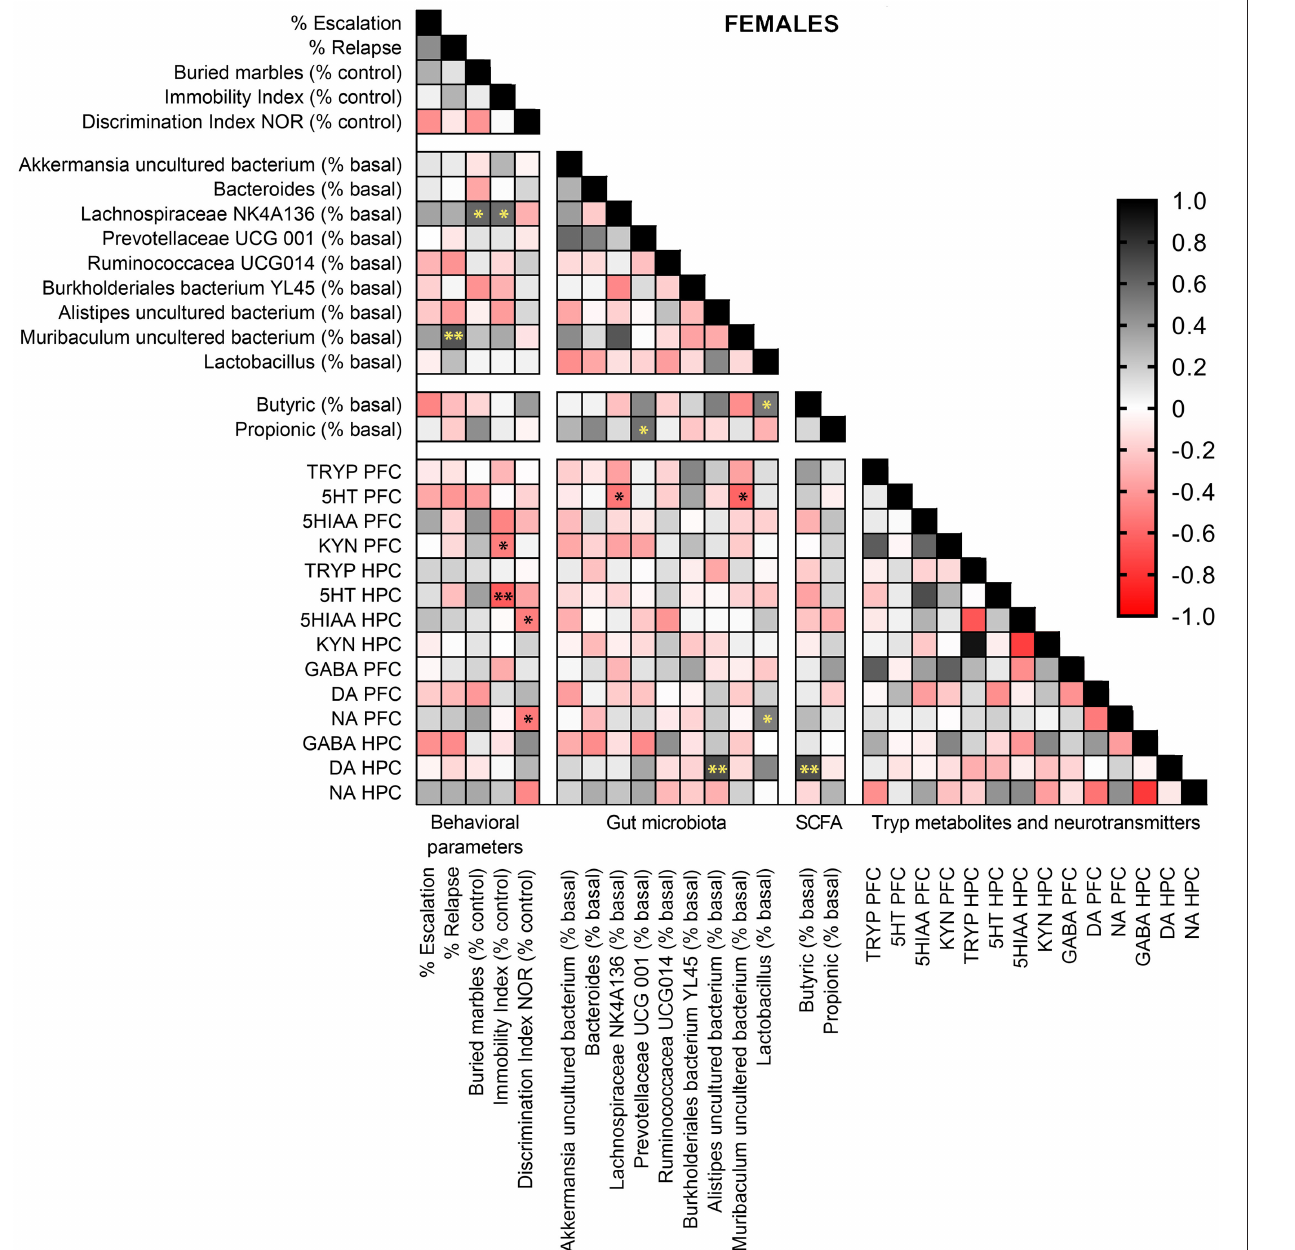
FIGURE 9 | Pearson correlation analysis in female mice exposed to alcohol-water and alcohol-synbiotic comparing behavioral parameters, including escalation (% baseline), relapse (% baseline), depression-like scores (immobility index), anxiety-like scores (buried marbles index), long-term memory (discrimination index in the NOR test) with gut microbial abundance, short-chain fatty acids (SCFA: butyric and propionic acids), tryptophan metabolites: Tryp (tryptophan), serotonin (5-HT), 5-hydroxyindolacetic acid (5-HIAA), kynurenine (KYN), and neurotransmitters including GABA, dopamine (DA) and noradrenaline (NA) concentrations in the prefrontal cortex (PFC) and hippocampus (HPC). Positive correlations are shown in black tones and negative correlations in red tones. Darker tones signify stronger correlations, with significance represented by asterisks (* p < 0.05, ** p <